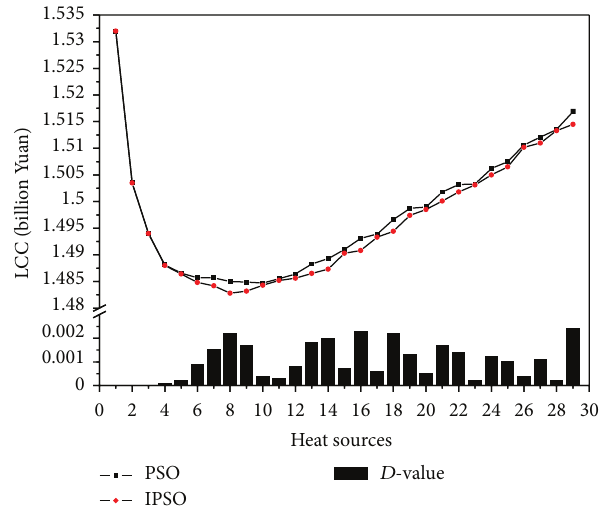
Figure 5: Algorithm calculation results comparison (optimum value).